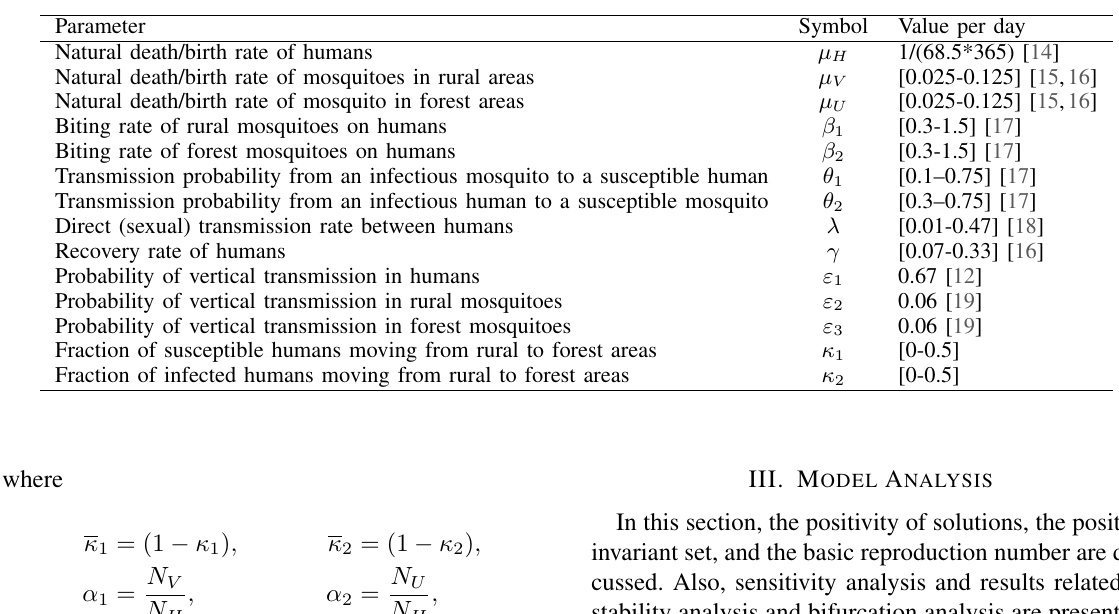
Fig. 2: Progression diagram of the proposed ZIKV model. Table I: Parameters used in the model